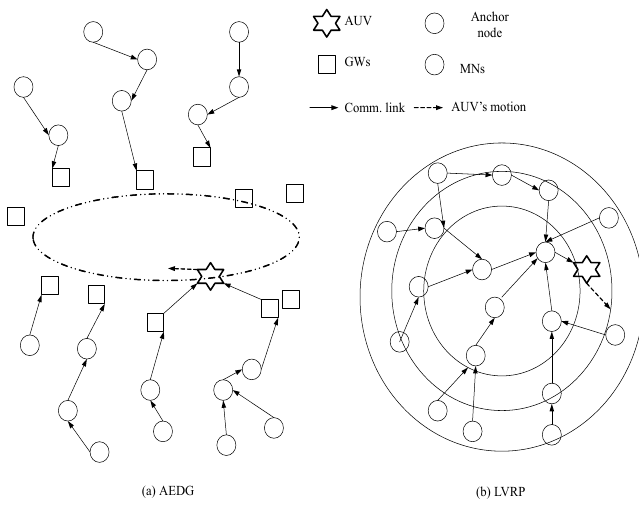
Figure 2. Network